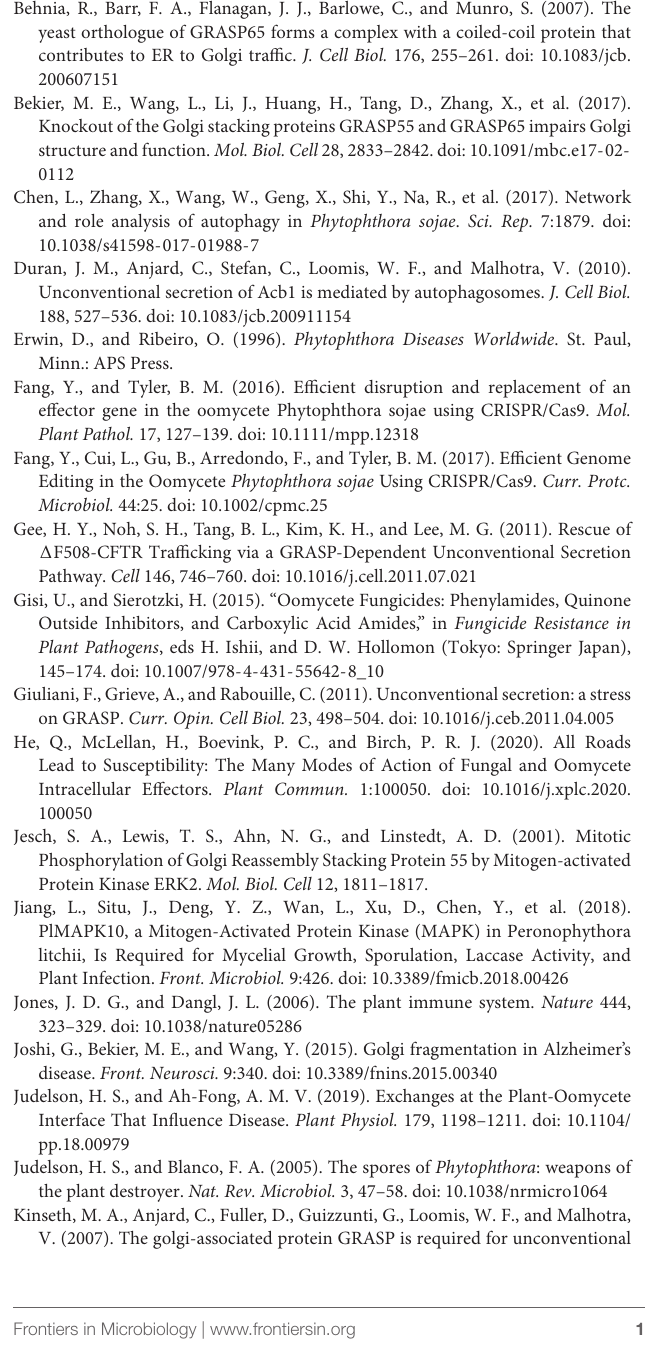
Supplementary Table 2 | Information about protein identification by label-free quantification. Supplementary Table 3 | Primers used in this